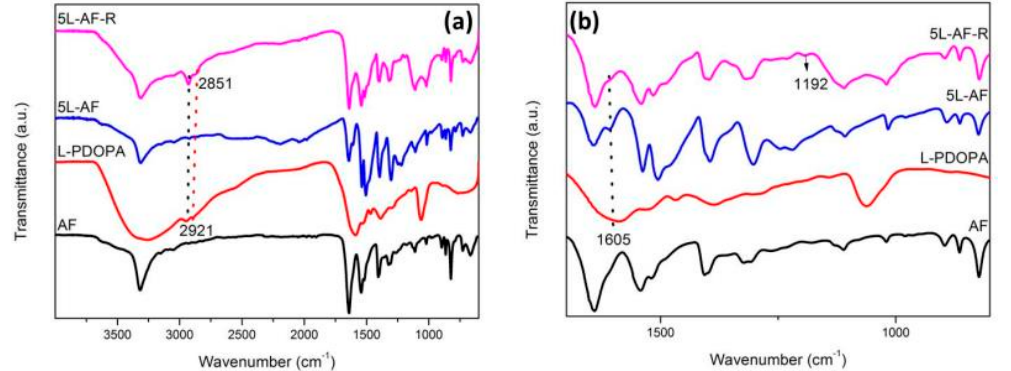
Figure 2. ( a ) The schematic diagram of layer-by-layer self-assembly of L -PDOPA for surface modification of aramid fibers and ( b ) electrostatic adsorption acidification of silane coupling agents